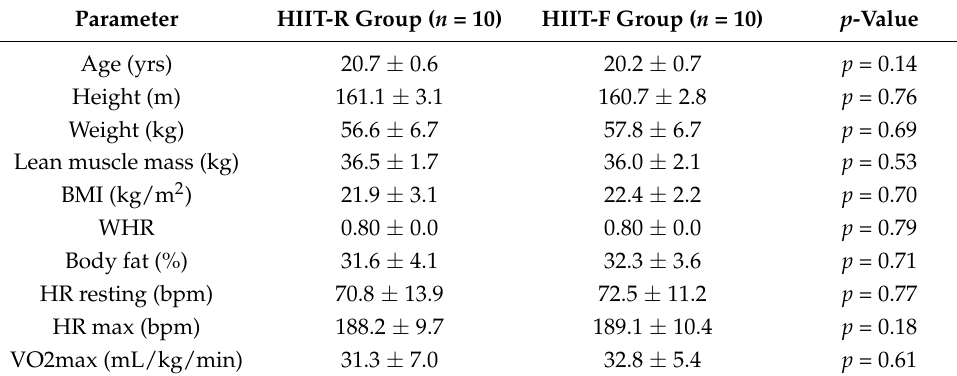
Table 1. Baseline characteristics of HIIT-R and HIIT-F